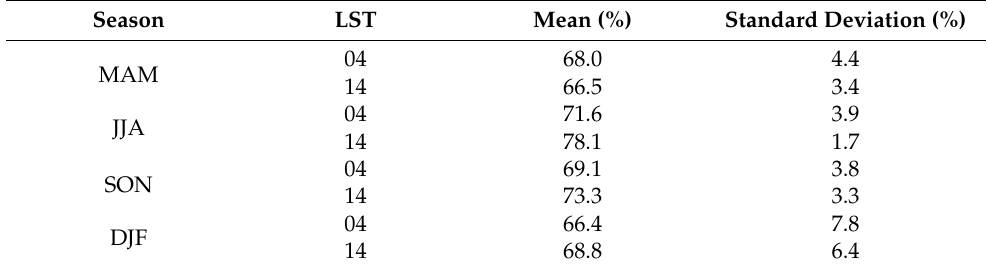
Table 1. Seasonal mean and standard deviation of CF over the seas in Arctic (60 ◦ ~90 ◦ N) at 04:00 LST and 14:00 LST during 1982–2019.